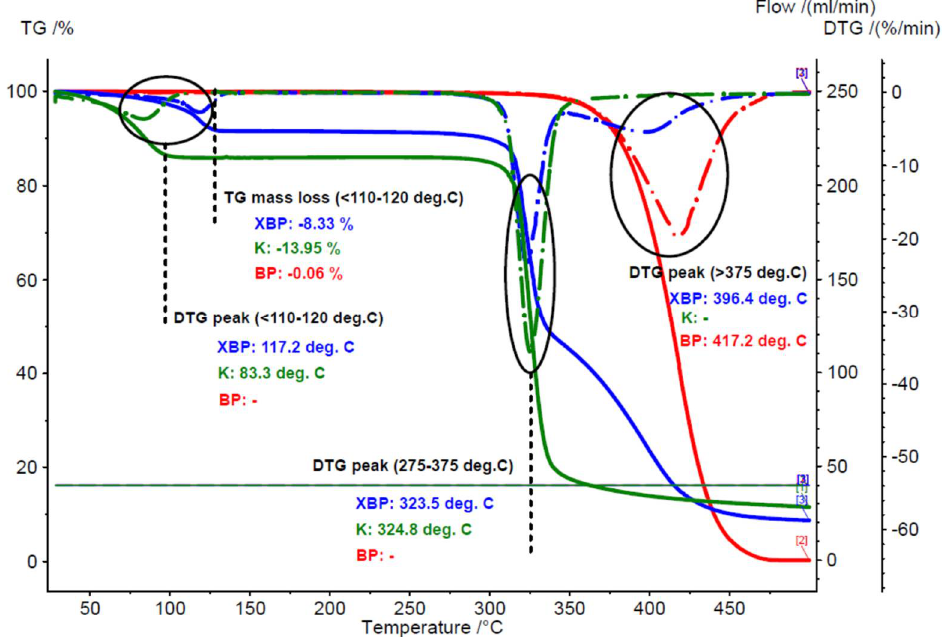
Figure 2. Superimposed TG–DTG thermograms for the β-cyclodextrin/processed (boiling) breast chicken lipid complex (blue), β-cyclodextrin hydrate (green), and processed (boiling) breast chicken lipid fraction (red) (codes “XBP”, “K” and “BP”, duplicate samples “a”).